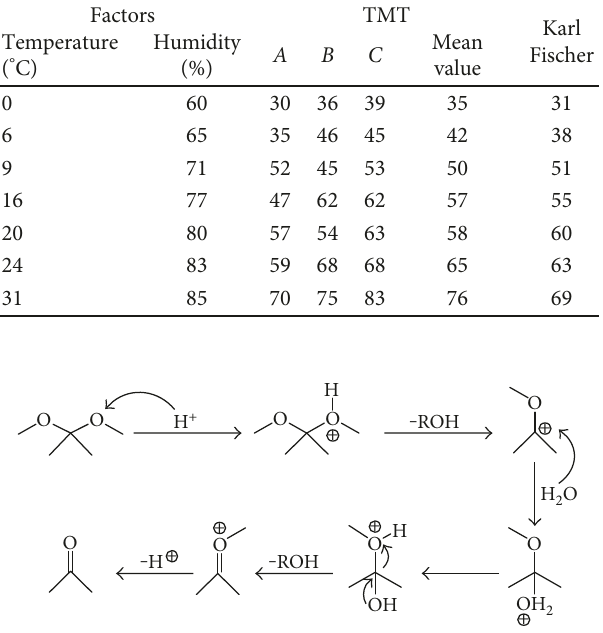
Figure 4: Proposed mechanism between DMP and H